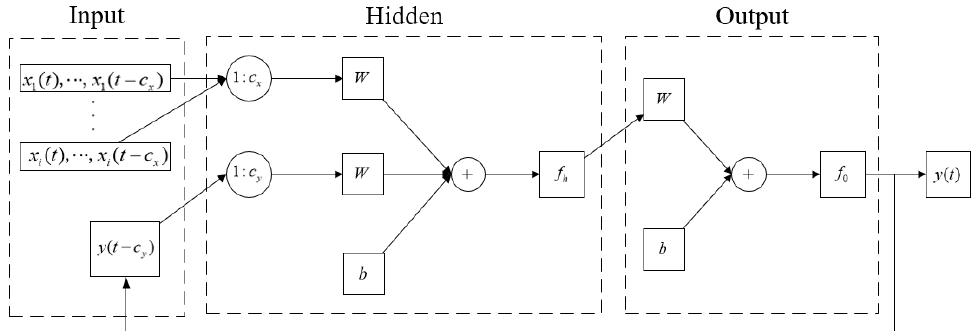
Figure 6. NARX grid structure for wind speed prediction.